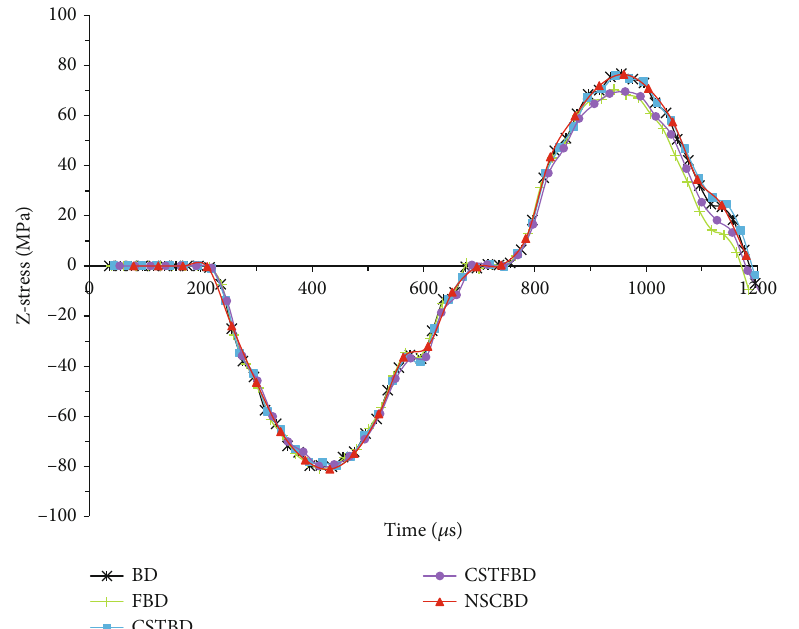
Figure 5: Stress waveforms on the incident bar of di ff erent models.